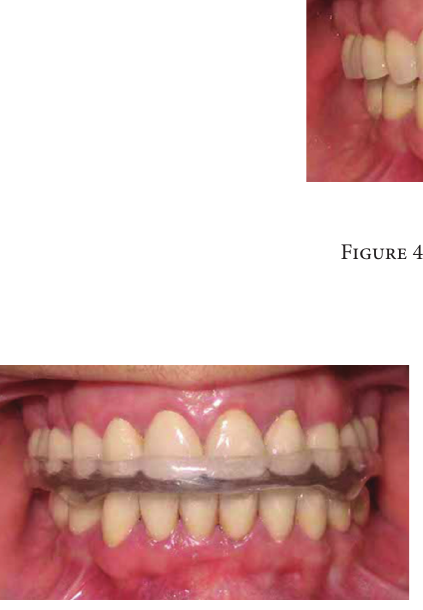
Figure 5: Frontal view of occlusal splint in the mouth.